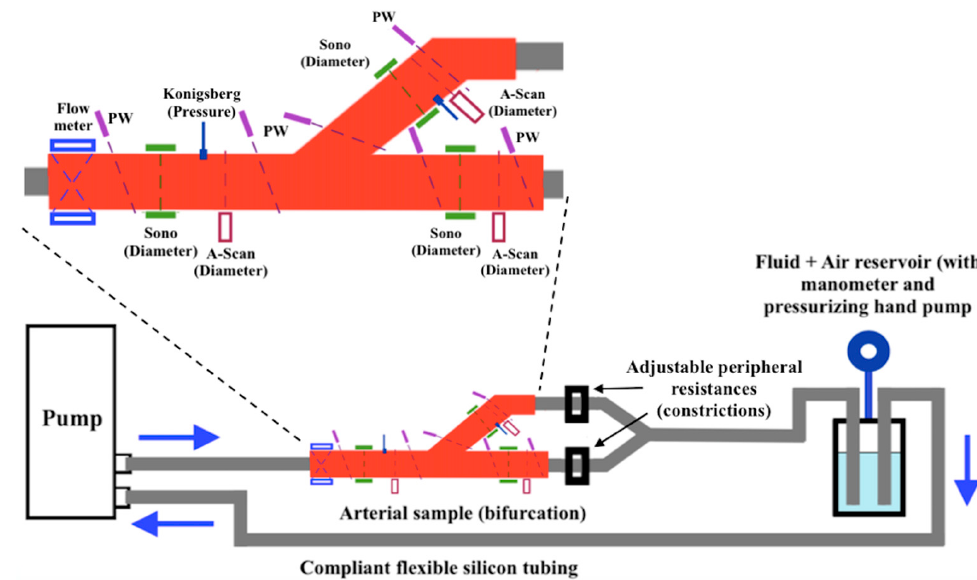
Figure 1. Example of experimental set-up for the study of arterial bifurcation in